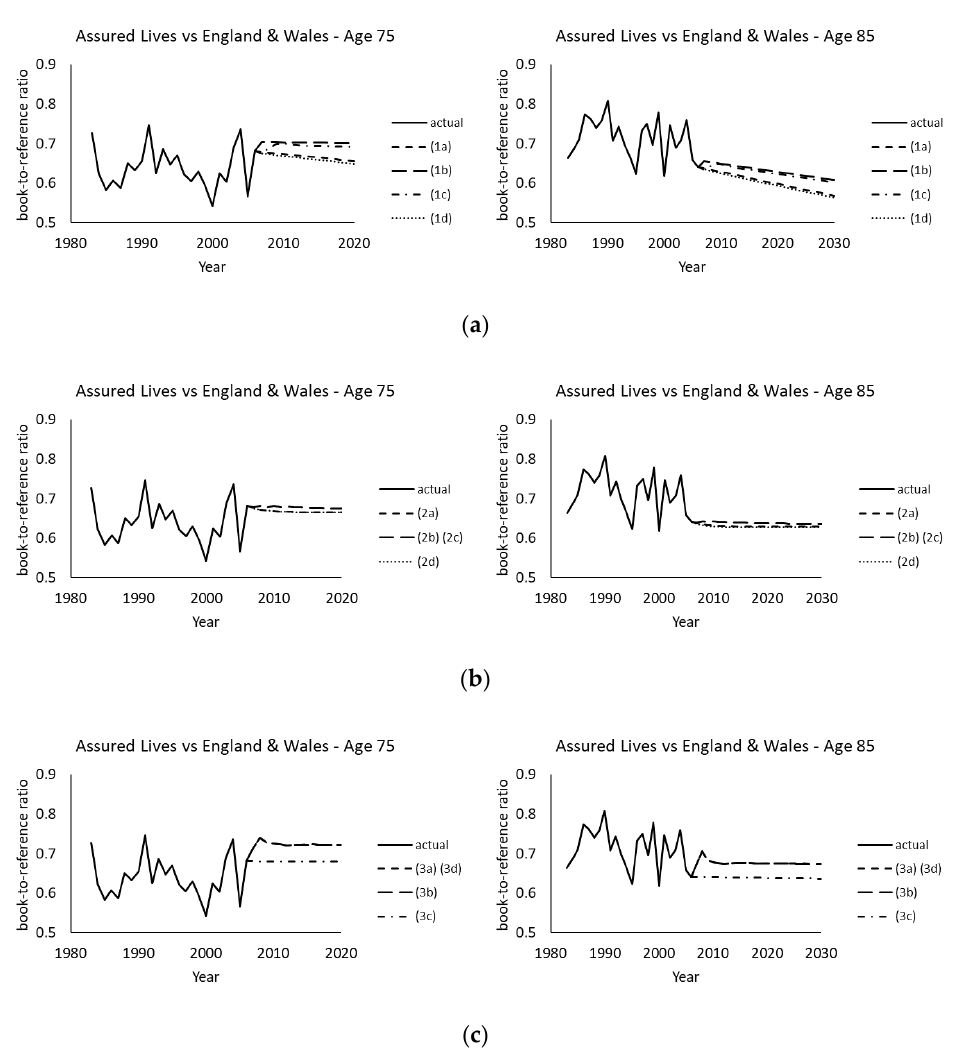
Figure 6. Projected (and observed) book-to-reference ratios of central death rates at ages 75 and 85 using assured lives (book) data and England and Wales (reference) data. ( a ) Model (1a) to (1d); ( b ) Model (2a) to (2d); ( c ) Model (3a) to (3d).